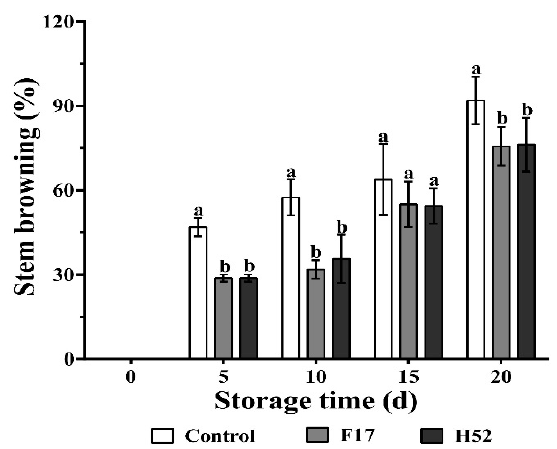
Figure 3. Changes in stem browning with different treatments during storage at 25 °C. Different lowercase letters at the same storage time indicate a significant difference ( p < 0.05).